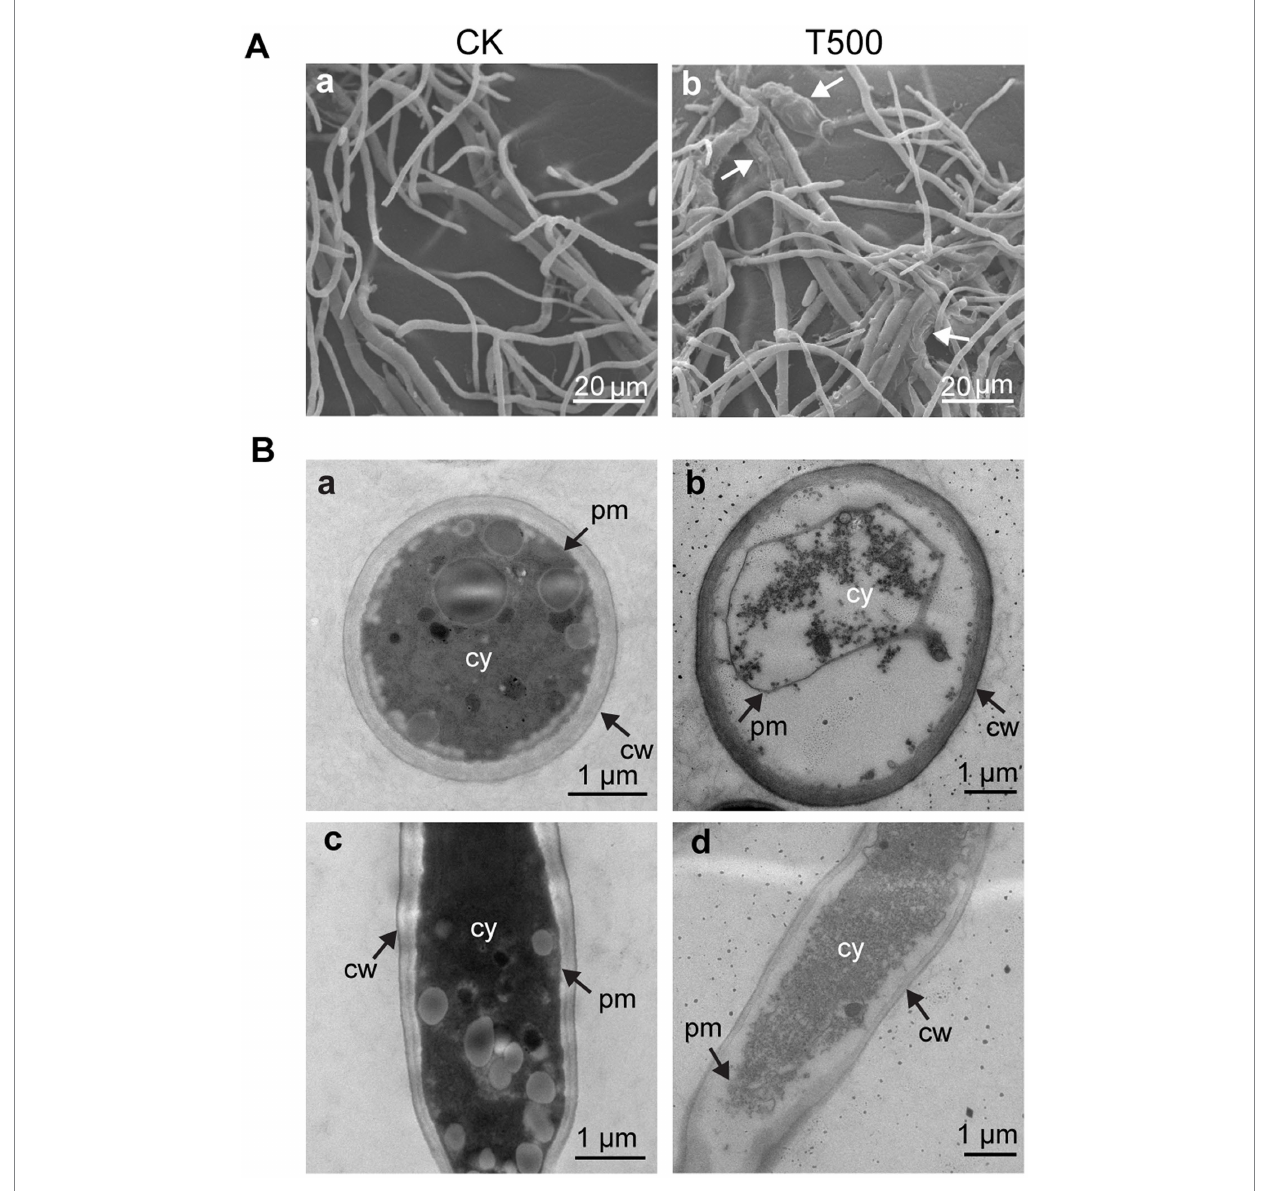
FIGURE 4 Effect of combined lipopeptin A and lipopeptin B treatment on the morphology and ultrastructure of Foc TR4 cells observed by SEM (A) and TEM (B) . CK, Foc TR4 hyphal cells treated with 50 μ g/mL blank culture medium (a and c in panels A , B ). T500, Foc TR4 hyphal cells treated with 500 μ g/mL purified lipopeptides (b and d in panels A , B ). The arrows in panel A indicate damaged mycelia of Foc TR4 in the presence of lipopeptides. cw, cell wall; pm, plasma membrane; cy,